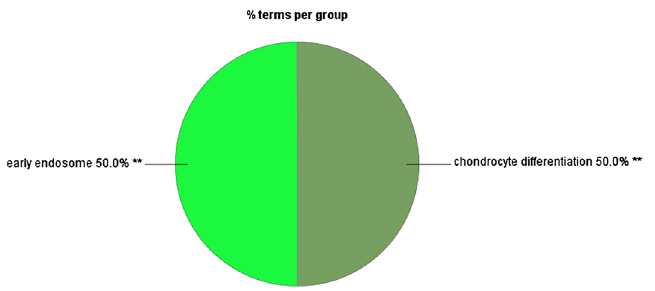
Figure 9. Results for enrichment analysis for target genes of gga-miR-1652: percentage of GOs for Kappa score